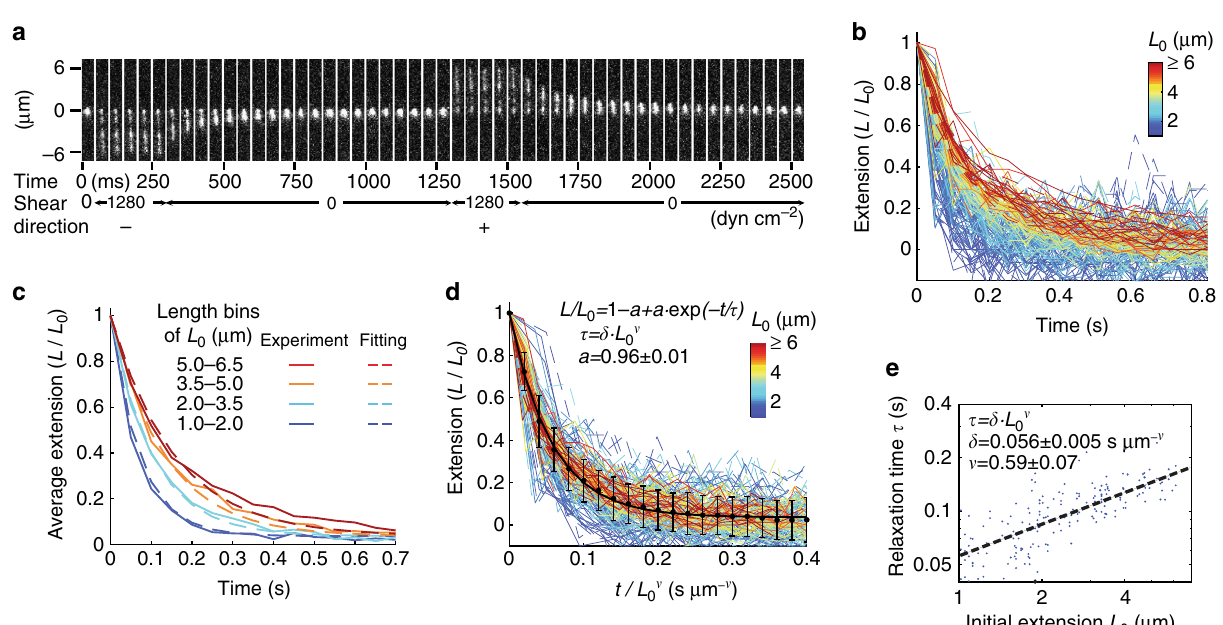
Fig. 2 VWF relaxation dynamics. a Successive 20 frames per second (fps) images of VWF extension in forward (+) and backward ( − ) fl ow at 1280 dyn cm − 2 and relaxation in absence of fl ow in buffer with 60% w/w sucrose and 150 mM NaCl. b Time course of VWF extension normalized to its initial value L 0 at 1280 dyn cm − 2 during relaxation from forward ( solid lines ) or backward ( dashed lines ) fl ows for 94 VWF concatemers (Supplementary Fig. 1c, d). c Average VWF relaxation dynamics ( solid lines ) in b for four L 0 bins with fi ts ( dashed lines ) from the equation shown in d . d , e Fits to the equations with 95% con fi dence intervals shown for VWF relaxation (Supplementary Fig. 1e, f). Points and error bars show mean and SD for all 94 concatemers relaxed from fl ow in both directions. The value of 0.96 for a suggests that we can account for 96% of the relaxation with a single exponential decay. There may be another component with a slower relaxation, but we could not measure it owing to the photobleaching that would occur during the long exposure required for its